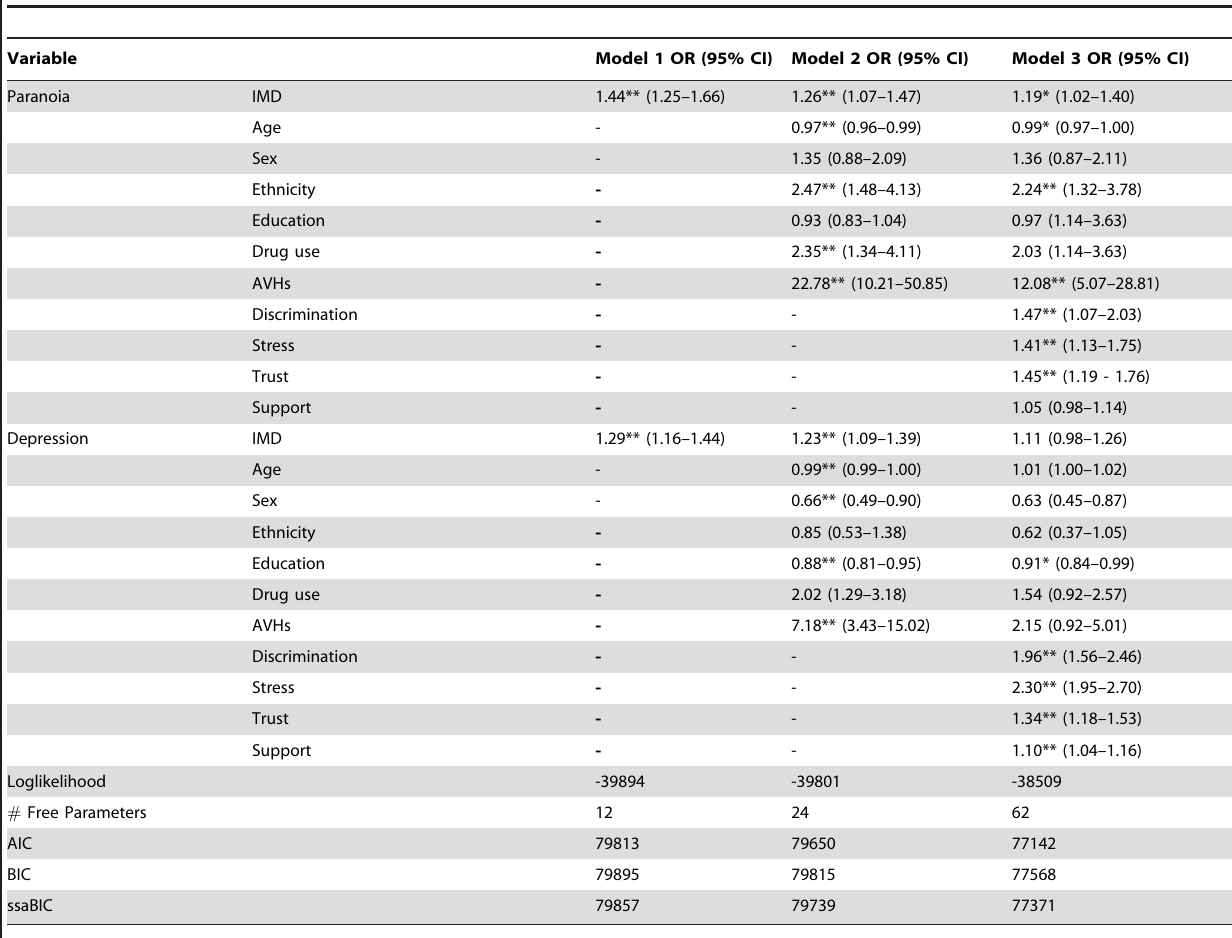
Table 3. Logistic regression odds ratios of symptoms by IMD and fit indices for the mediation